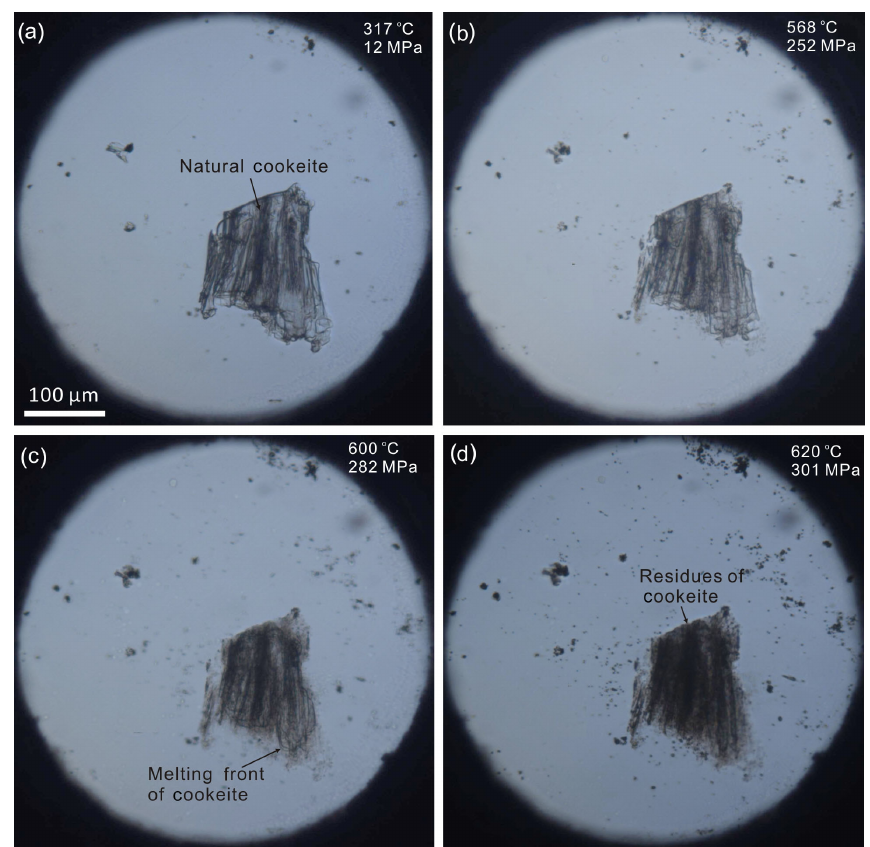
Figure 6. Images of the HDAC sample chamber during the cookeite dissolution and melting experiment: (a) natural cookeite surrounded by pure water at 12MPa and 317 ◦ C; (b) cookeite dissolving in water at 252MPa and heated to 568 ◦ C at 5 ◦ Cmin − 1 ; (c) cookeite dissolving and melting at 282MPa and 600 ◦ C (heated at 1 ◦ Cmin − 1 ), showing the cookeite melting front; and (d) cookeite residue after dissolution of the main part in water at 301MPa and 620 ◦ C (heated at 1 ◦ Cmin − 1 ). This residue remained even at 486MPa and 820 ◦ C. Pressures were calculated for a bulk H 2 O density of 0.67681gcm − 3